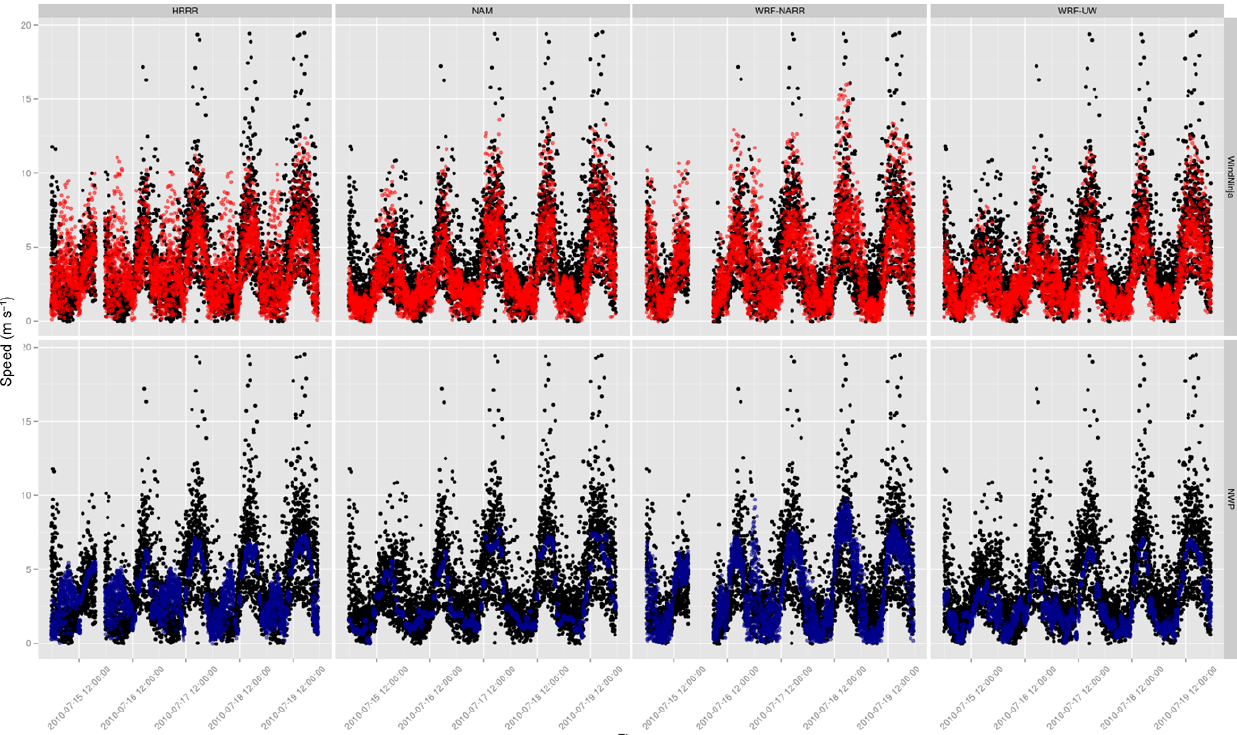
Figure 3. Observed (black) and predicted (colored) winds speeds at all sensors for 15–19 July 2010 at Big Southern Butte. Top panels are WindNinja predictions. Bottom panels are NWP